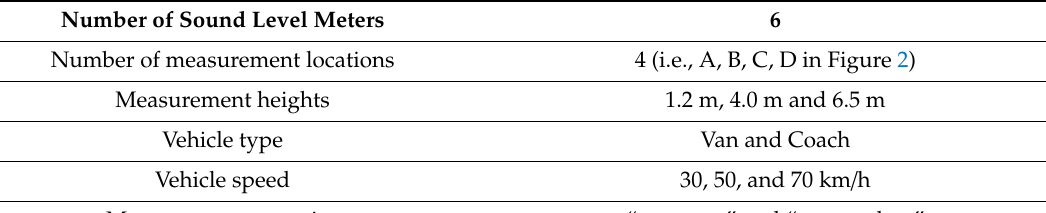
Table 1. Summary of the measurement information.